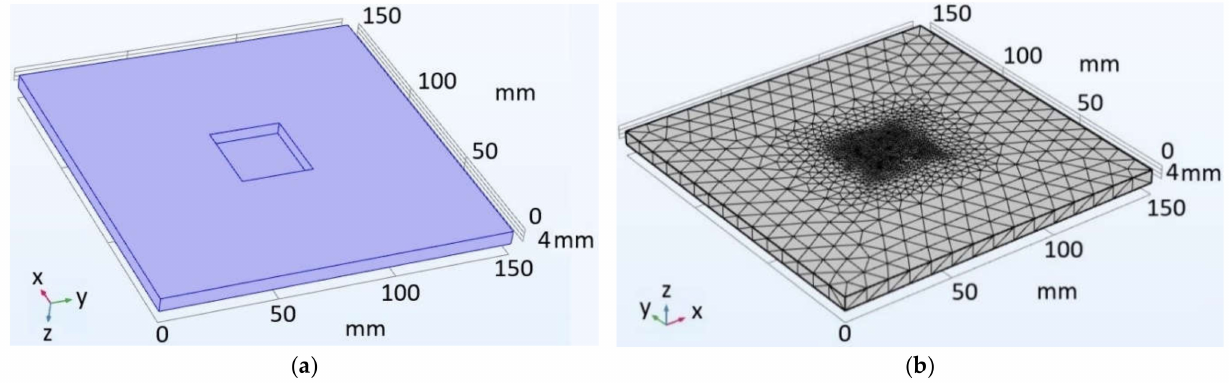
Figure 3. Finite-element FBH model ( a ) and numerical mesh ( b